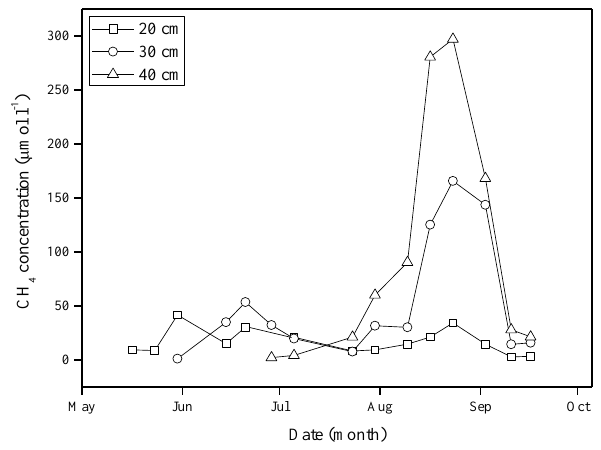
Fig. 4. Seasonal variation of dissolved pore water CH 4 concentra- tions at different soil depths was determined for the study site during sampling in